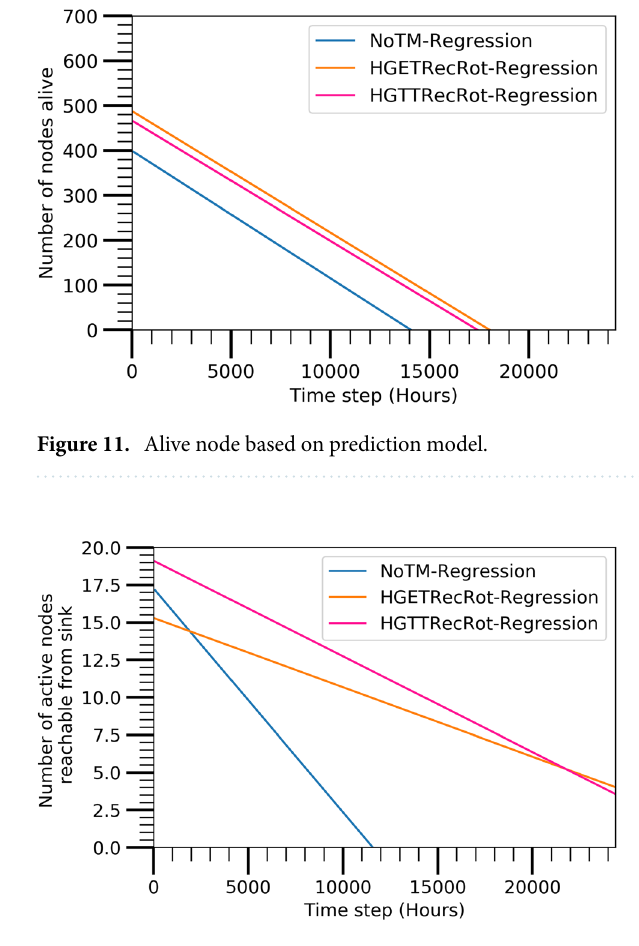
Figure 12. Active nodes reachable from sink based on prediction model.